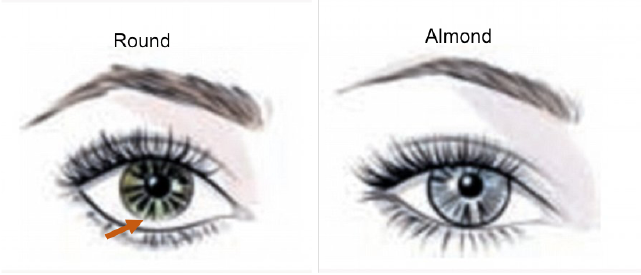
shape as follows: